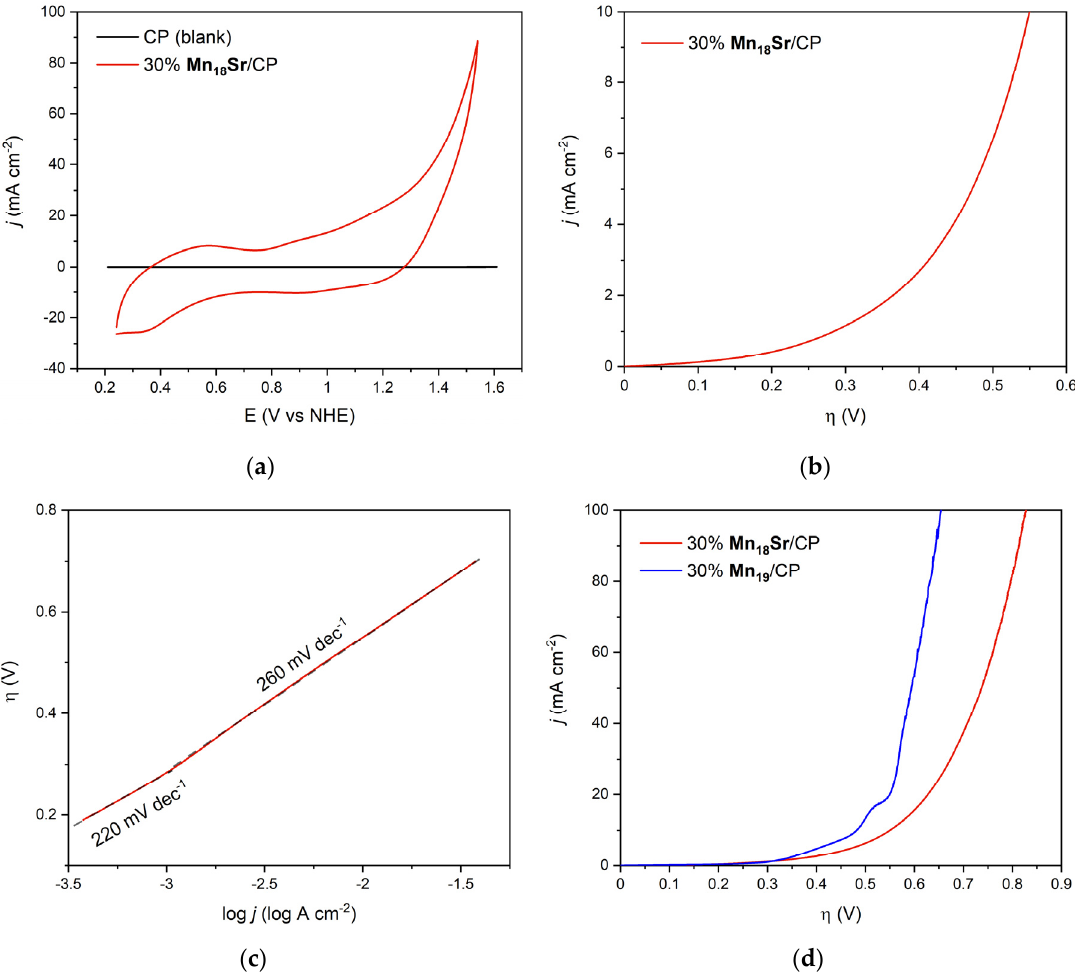
Figure 2. Water oxidation electrocatalytic activity of 30% Mn 18 Sr /CP working electrodes performed in a 50 mM KP i aqueous buffer at pH = 7.2 using KNO 3 (1 M) as electrolyte. ( a ) Cyclic voltammograms comparing Mn 18 Sr /CP (red) versus catalyst-free CP (black) electrodes. ( b ) Linear sweep voltammetry. ( c ) Tafel plot. The red line shows the data extracted from the LSV measurement, while the black dashed lines highlight the two different Tafel slopes. ( d ) Linear sweep voltammetry of a 30% Mn 18 Sr /CP working electrode (red) compared to that of a 30% Mn 19 /CP working electrode (blue).